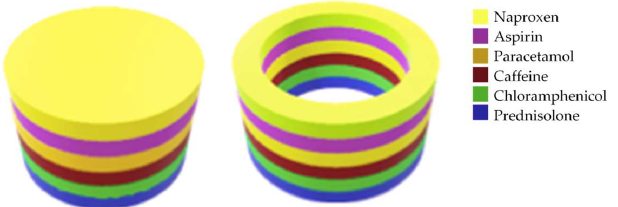
Figure 1. 3D designs of the printlets. Type I: Cylinder ( left , 10 mm diameter and 3 mm height), Types II and III: Ring ( right , 10 mm diameter and 6 mm height).